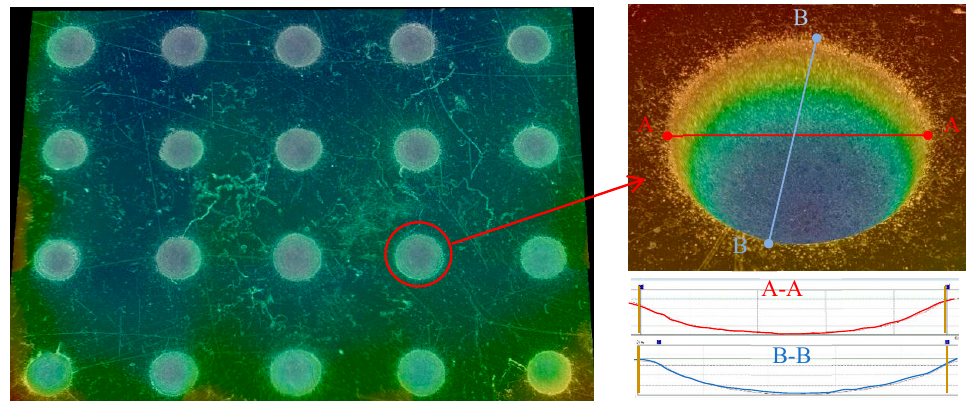
Figure 3. Three-dimensional profile of micro-dimple arrays machined in the single-travel mode and Figure 3. Three ‐ dimensional profile of micro ‐ dimple arrays machined in the single ‐ travel mode and Micromachines 2020, 11, 188 under the magnetic field (single-travel time of 0.3 s and 8.5 V). under the magnetic field (single ‐ travel time of 0.3 s and 8.5 V).